Question: Write a descriptive caption for this figure.
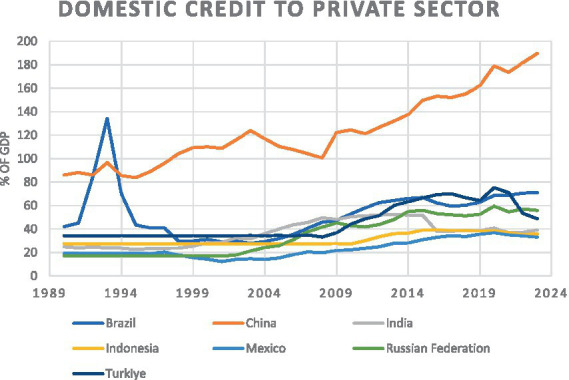
Answer: Annual trend of DCPS in E7 nations during the study span.